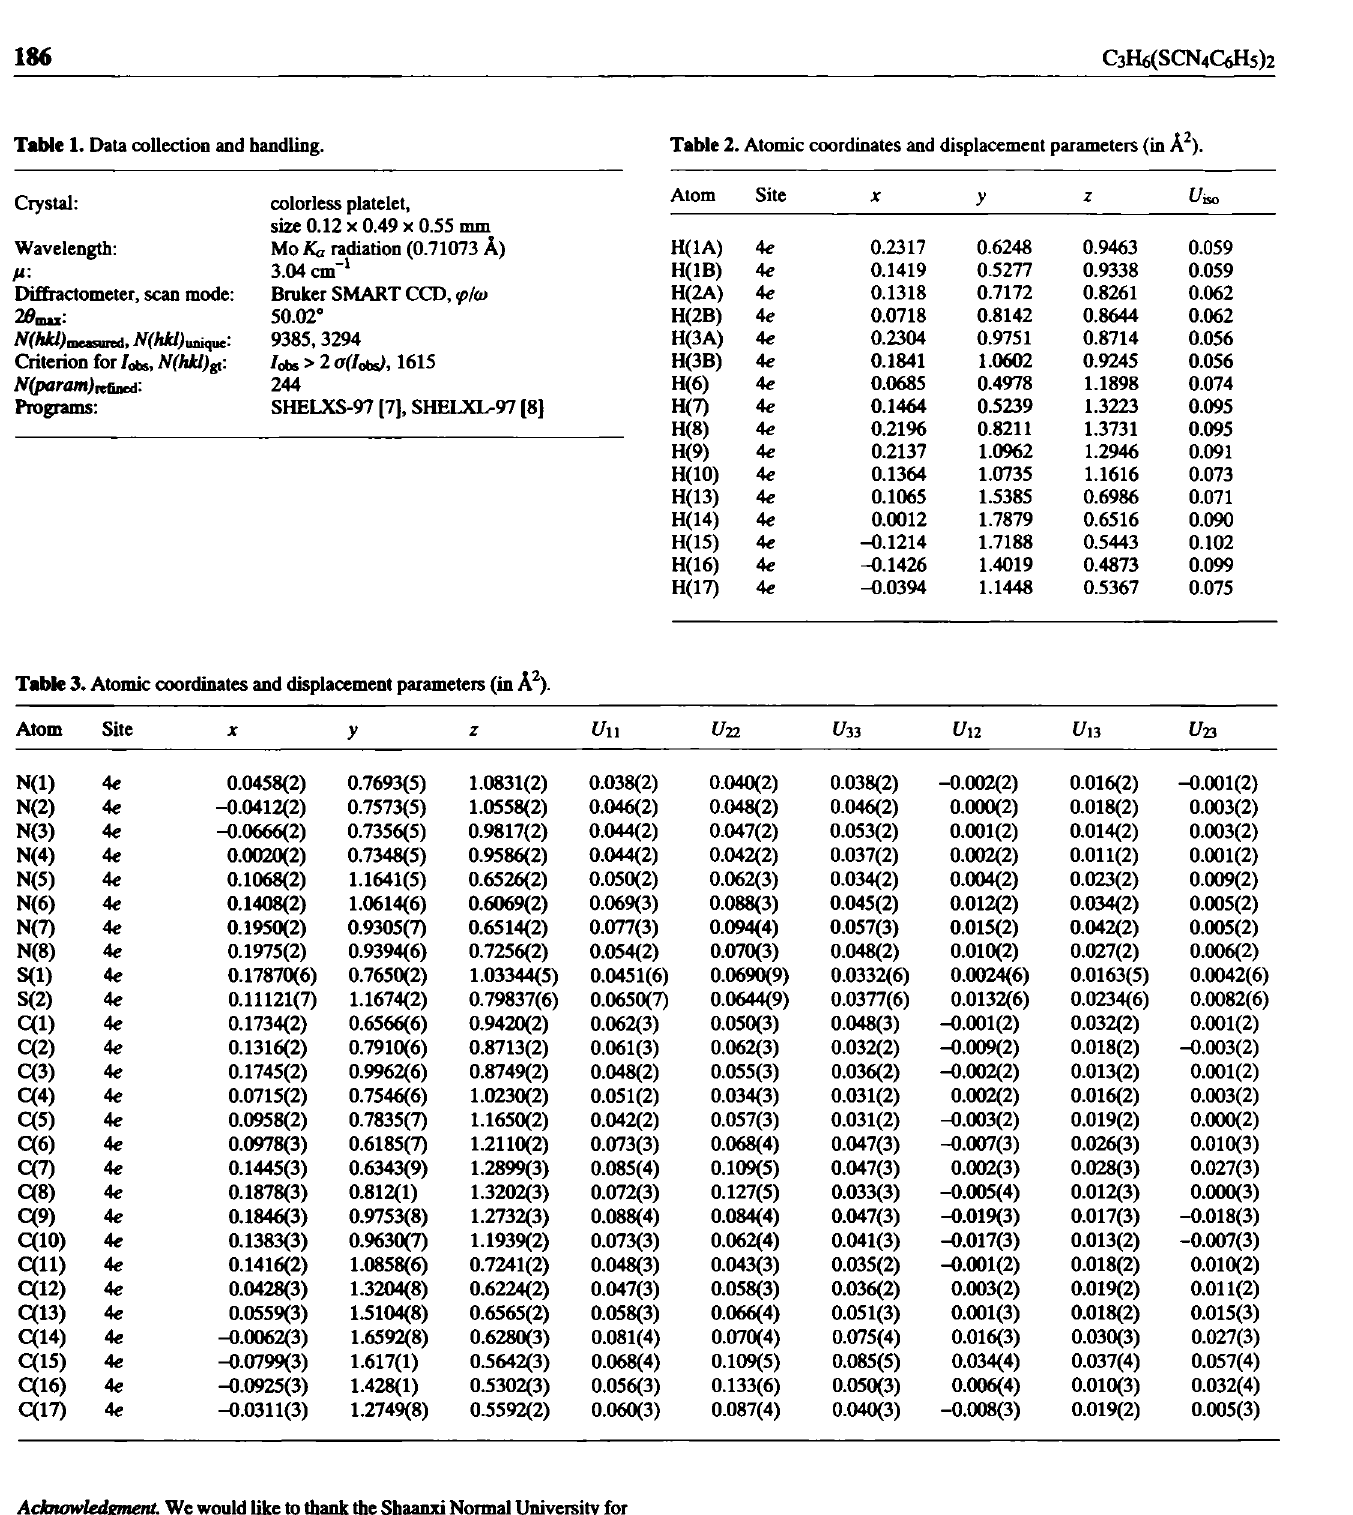
Table 1. Data collection and handling. Table 2. Atomic coordinates and displacement parameters (in A 2 ).